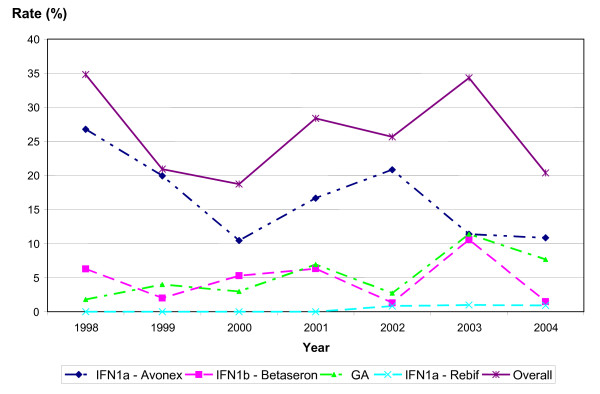
Estimated IMA prescription percentages in return visits, NAMCS data, 1998–2004.